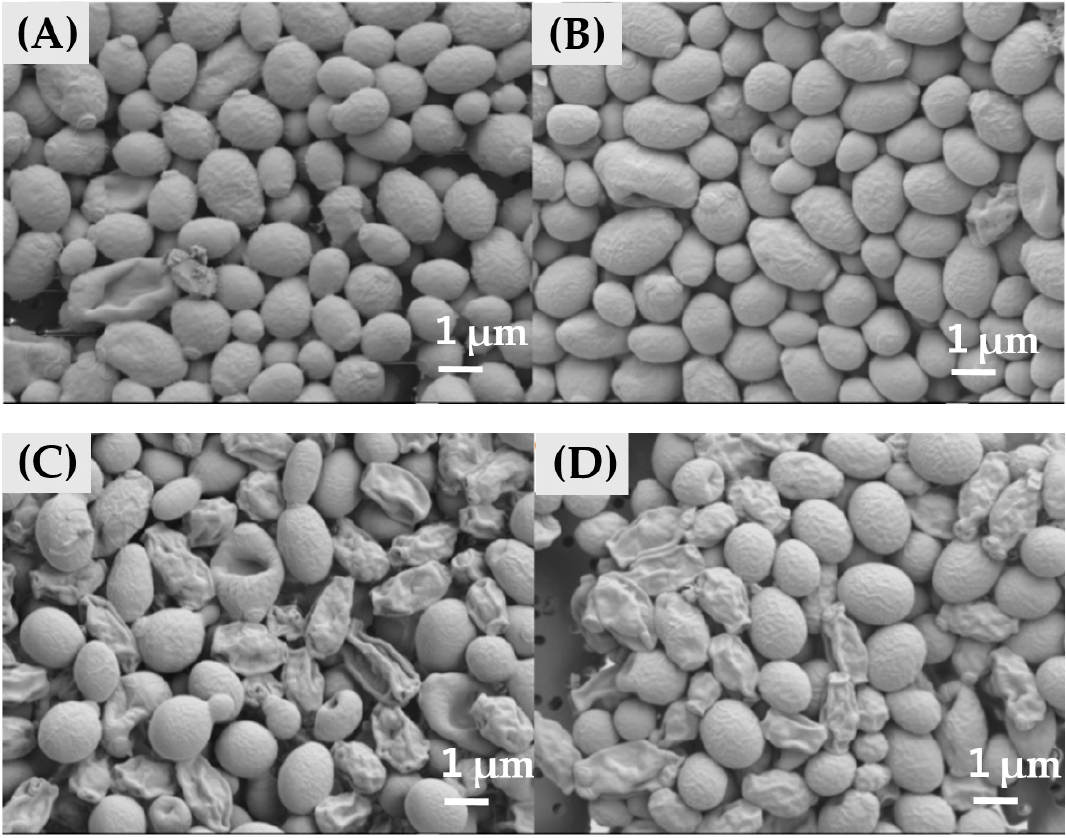
Figure 6. Scanning electron microscopy images of C. albicans cells. ( A ) Control; ( B ) in the presence of CKR12-PLGA = 64 µ M; ( C ) in the presence of MCZ = 199 µ M; ( D ) in the presence of CKR12-PLGA-MCZ = 64 µ M.